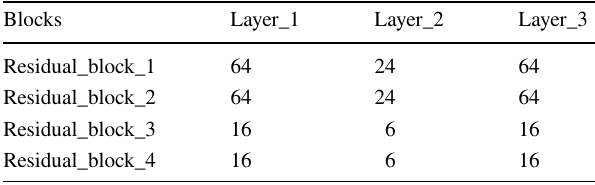
Table 8 The filter parameters of dilated casual convolution